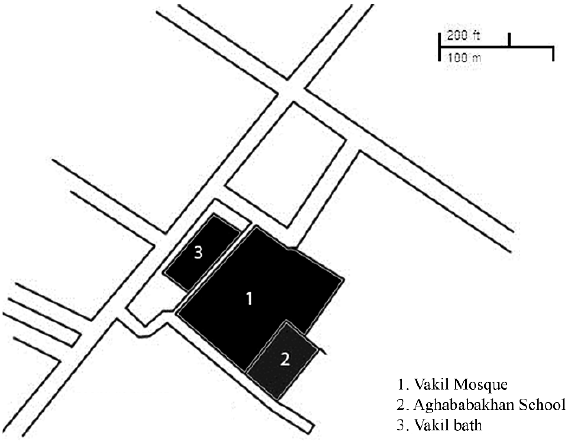
fig. 8. Placement of the school next to the mosque